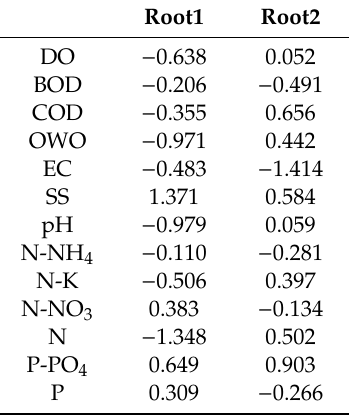
Table 6. Standardized canonical discriminant function coe ffi